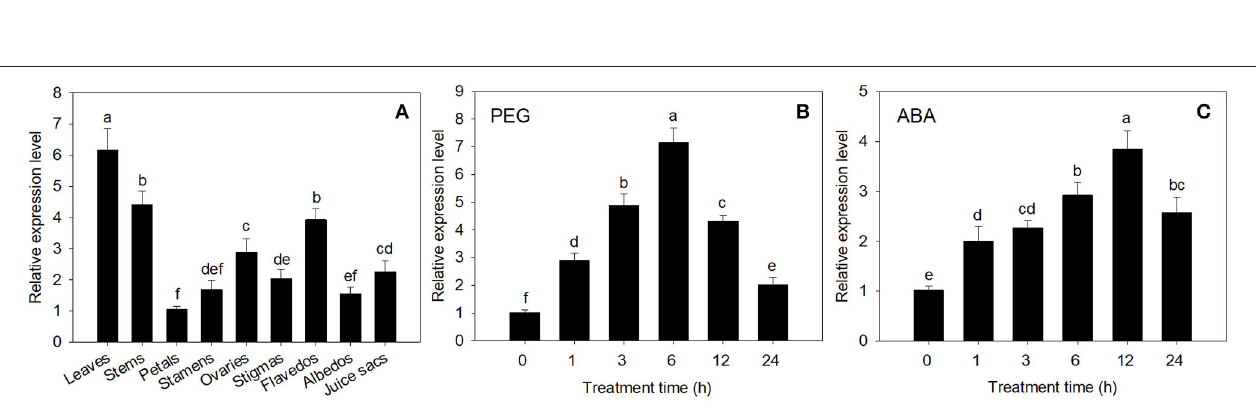
FIGURE 2 | The expression analysis of CsECR in “Newhall” navel orange. (A) The expression of CsECR in different organs. (B,C) The expression patterns of CsECR in leaves of “Newhall” navel orange after drought (20% PEG 6000) and ABA (100 µ M) treatments. The y-axis records the relative gene expression levels as calculated by the 2 − 11 CT method with β -actin as the endogenous reference. Vertical bars represent standard deviations of the means ( n = 3). Different small letters represent significant differences at P < 0.05 according to Duncan’s multiple range tests.